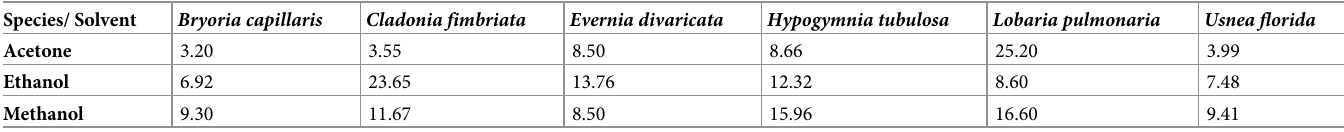
Table 2. The actual yields of the prepared dry extracts of